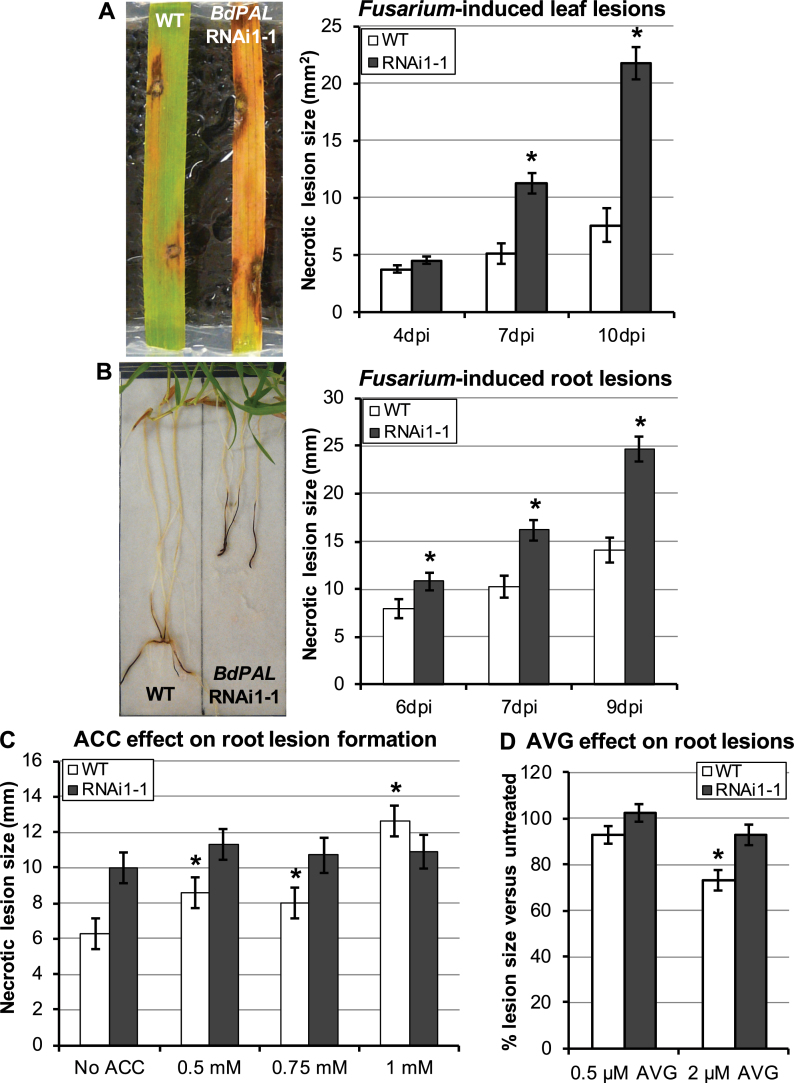
Effect of BdPAL silencing on Fusarium disease resistance. (A) Comparison of the foliar necrotic lesions that developed on wounded leaves of WT Bd21-3 and BdPAL RNAi1-1 following F. culmorum infection. The image shows necrotic lesions 7 days post-infection (dpi). n=32. (B) Comparison of the root necrotic lesion sizes developed on WT and BdPAL RNAi1-1 roots following F. culmorum infection. 22<n<24. Image shows seedlings 9 dpi. Asterisks in (A) and (B) represent Student’s t-test P-value <0.001, comparing BdPAL RNAi1-1 with the WT for a given time point. (C, D) Comparison of the effect of ACC (C) and AVG (D) treatments on the necrotic lesion sizes developed on WT and BdPAL RNAi1-1 roots, 7 d following F. culmorum infection. 20<n<24. For (C, D), asterisks represent Student’s t-test P-values <0.001, which relate to the comparison of each treatment with its corresponding untreated control. For all graphs, error bars represent the standard error (SE).